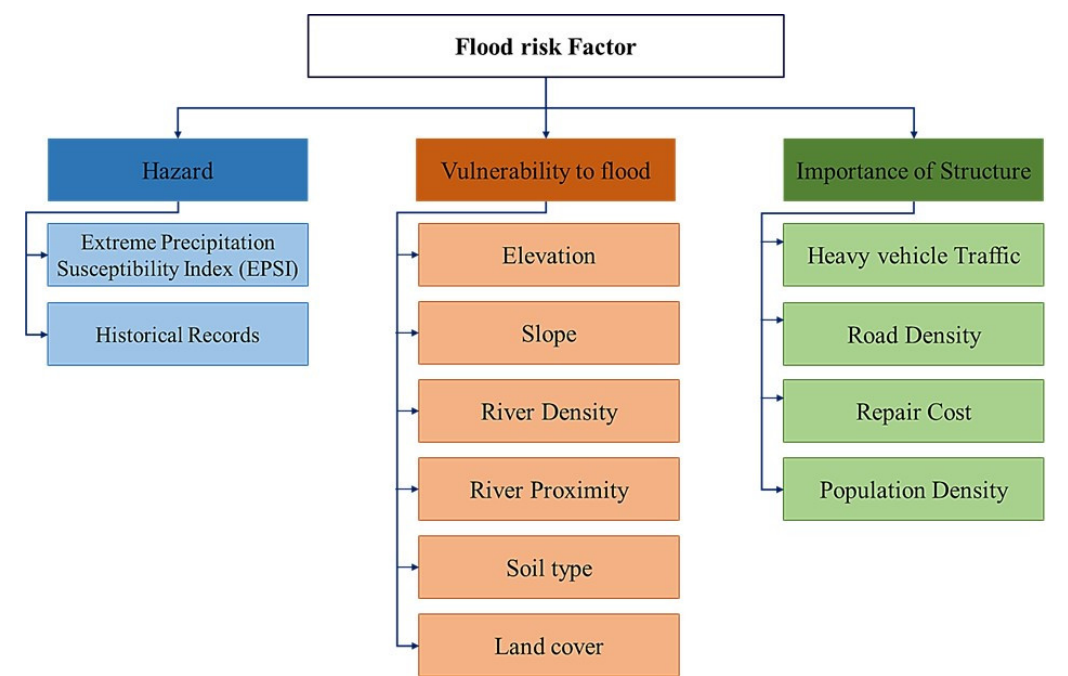
Figure 2. Factors affecting the risk of floods on road